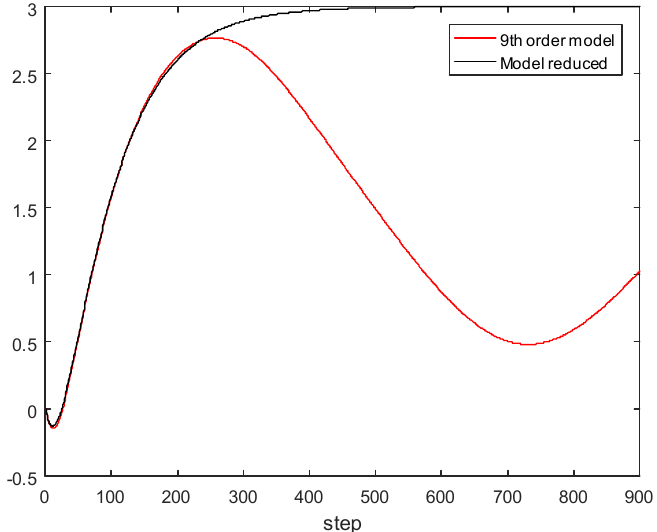
Figure 13. Comparison of the 6th and 9th order models—simulation of 900 time-steps (solid line—9th order model, dashed line—6th order model—model after order reduction).